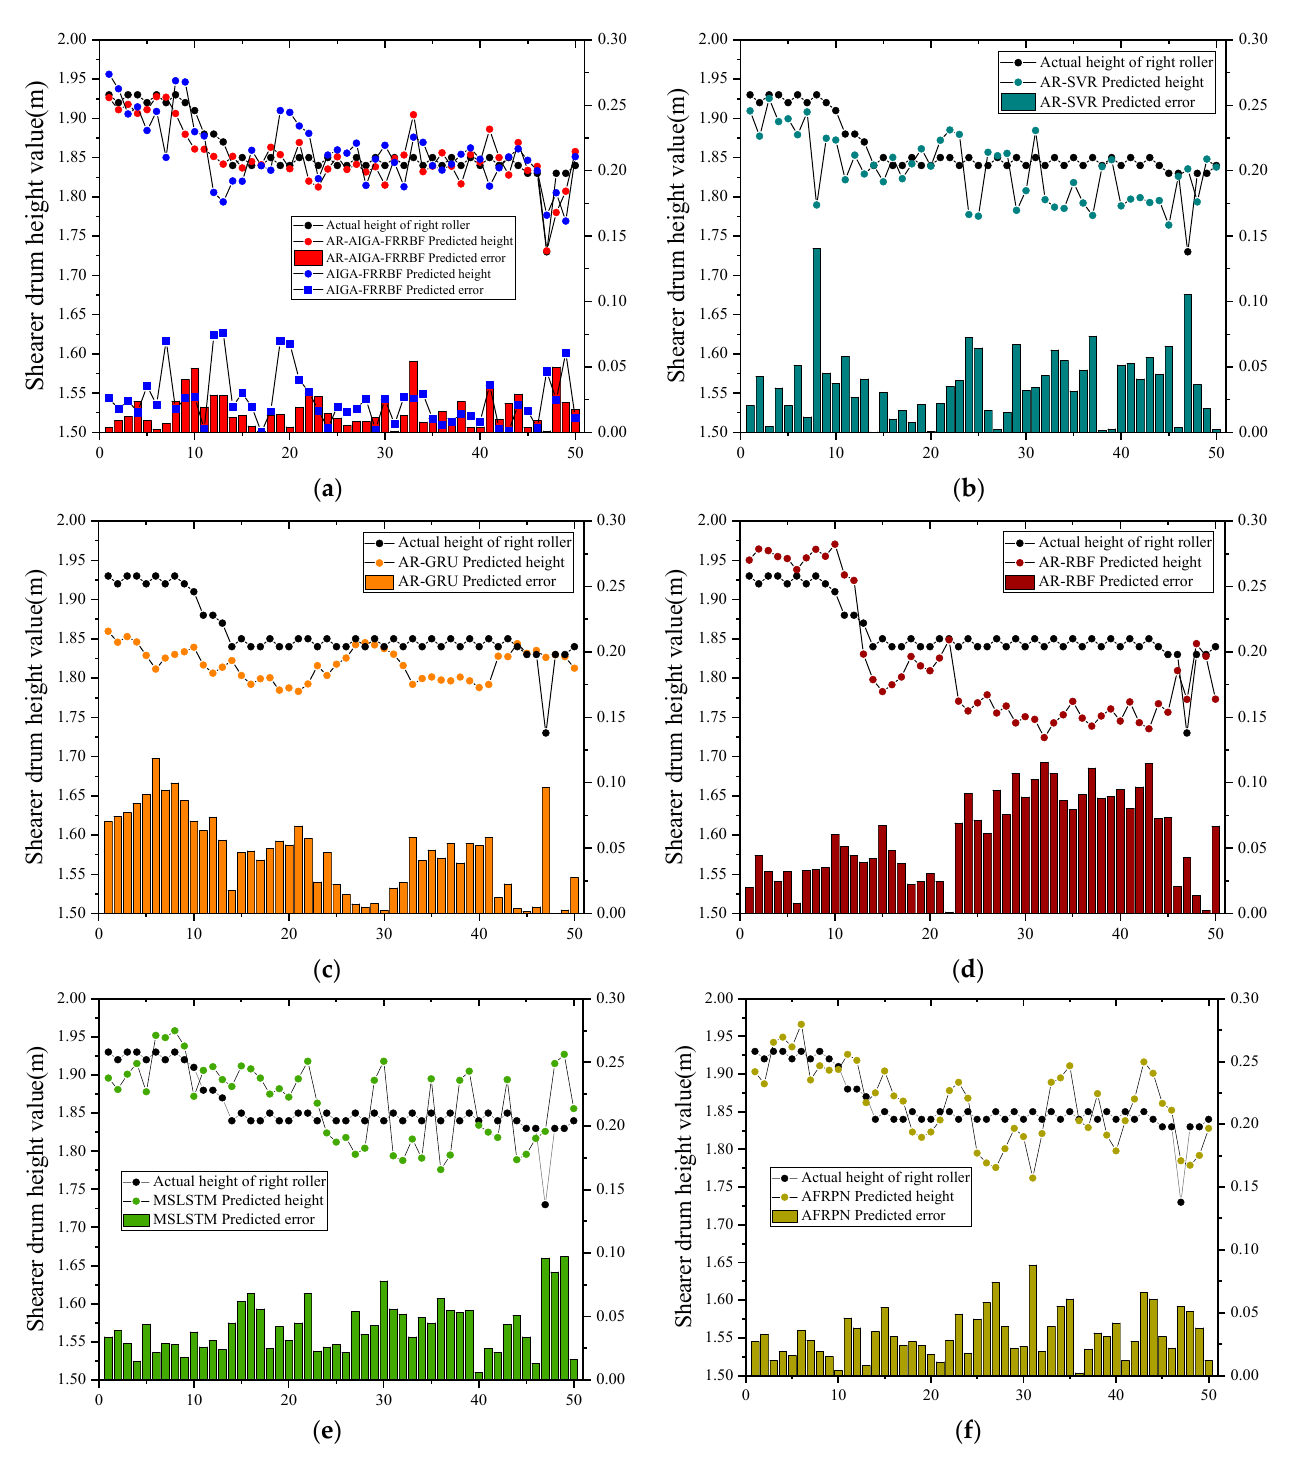
Figure 6. Comparison of height prediction of left drum of shearer with different model.